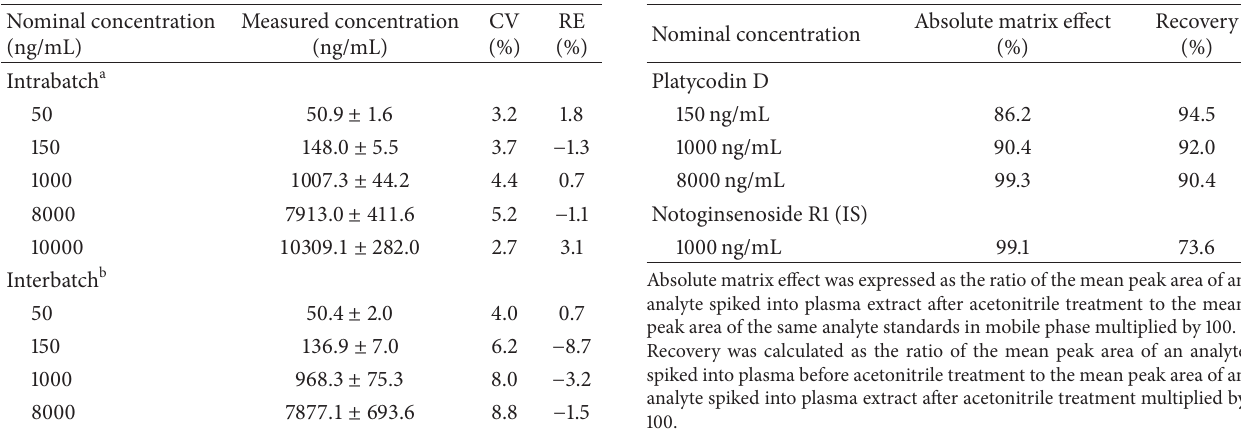
Table 3: Recovery and matrix effect of platycodin D and IS in rat plasma ( 𝑛 = 4 at each